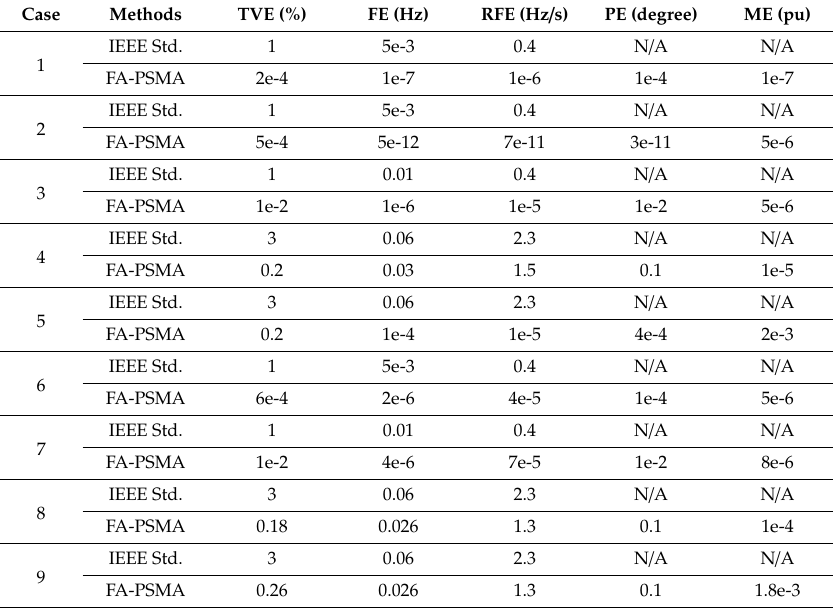
Table 3. The maximum measurement errors of